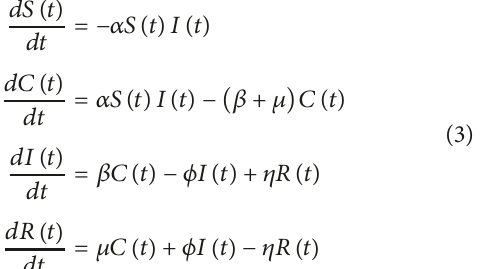
rumors and have not decided whether to spread